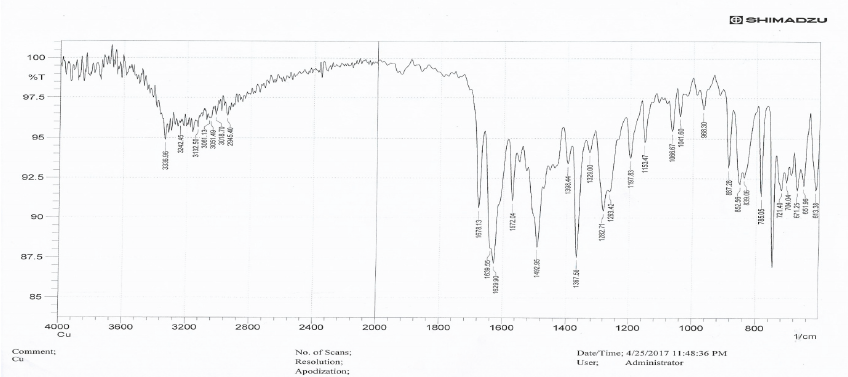
Figure 3: The IR spectra of the complex [Cu(L1)(L2) H 2 OCl].